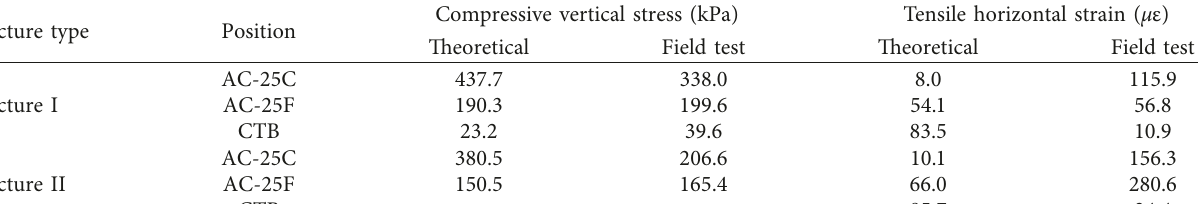
Table 7: Theoretical results.